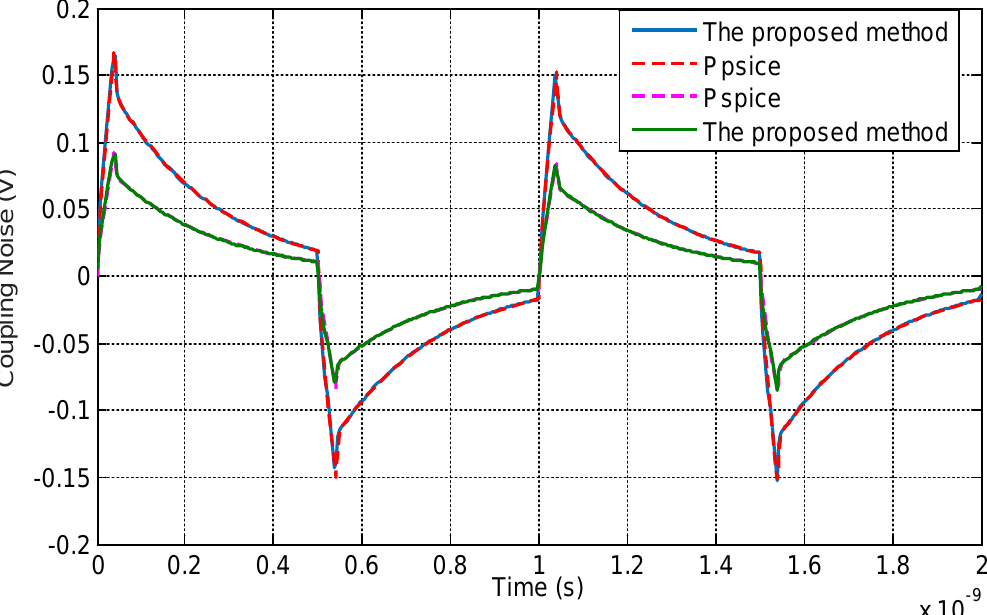
Figure 12. The proposed method and Pspice simulation of the coupling noise of TSV–TSV (V in = 1 V and 1.8 V).